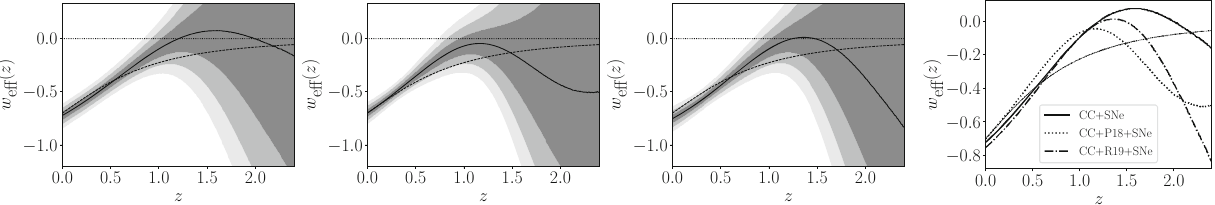
0 . 0 Fig. 12 Plots for the effective equation of state parameter, from the reconstructed deceleration q , for combined CC + Pantheon data (left), CC + Pantheon + P18 data (second from left) and CC + Pantheon + R19 data (third from left). The black dashed line represents the effective EoS for (cid:2) CDM model, considering (cid:12) m 0 = 0 . 3. A comparison among the three results is given in the extreme